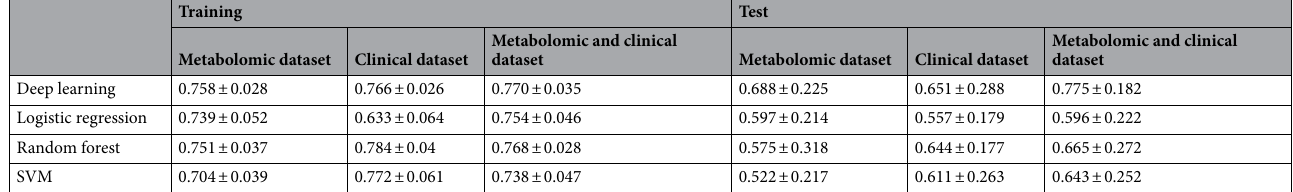
Table 2. Comparison of four analysis methods.